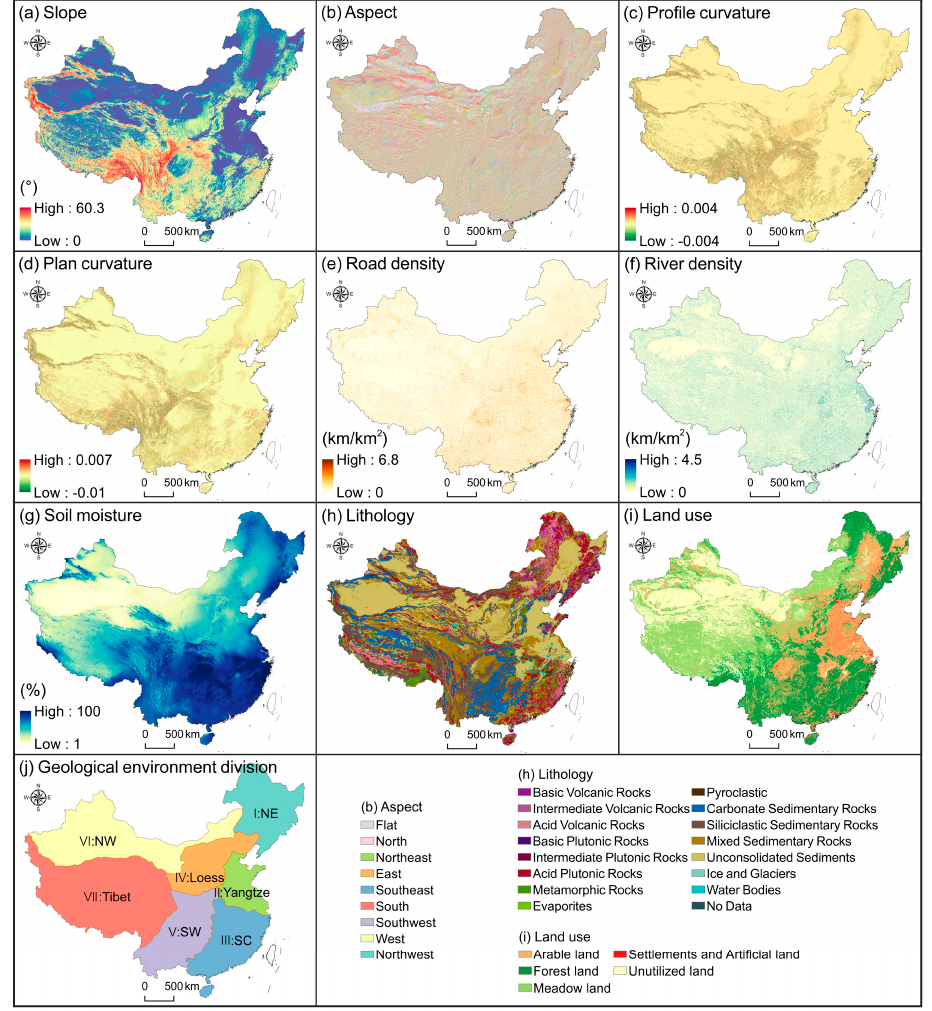
Figure 3. Spatial distribution map of influencing factors. ( a ) slope; ( b ) aspect ( c ) profile curvature; ( d ) plan curvature; ( e ) road density; ( f ) river density; ( g ) soil moisture; ( h ) lithology; ( i ) land use ( j ) geological environment division.